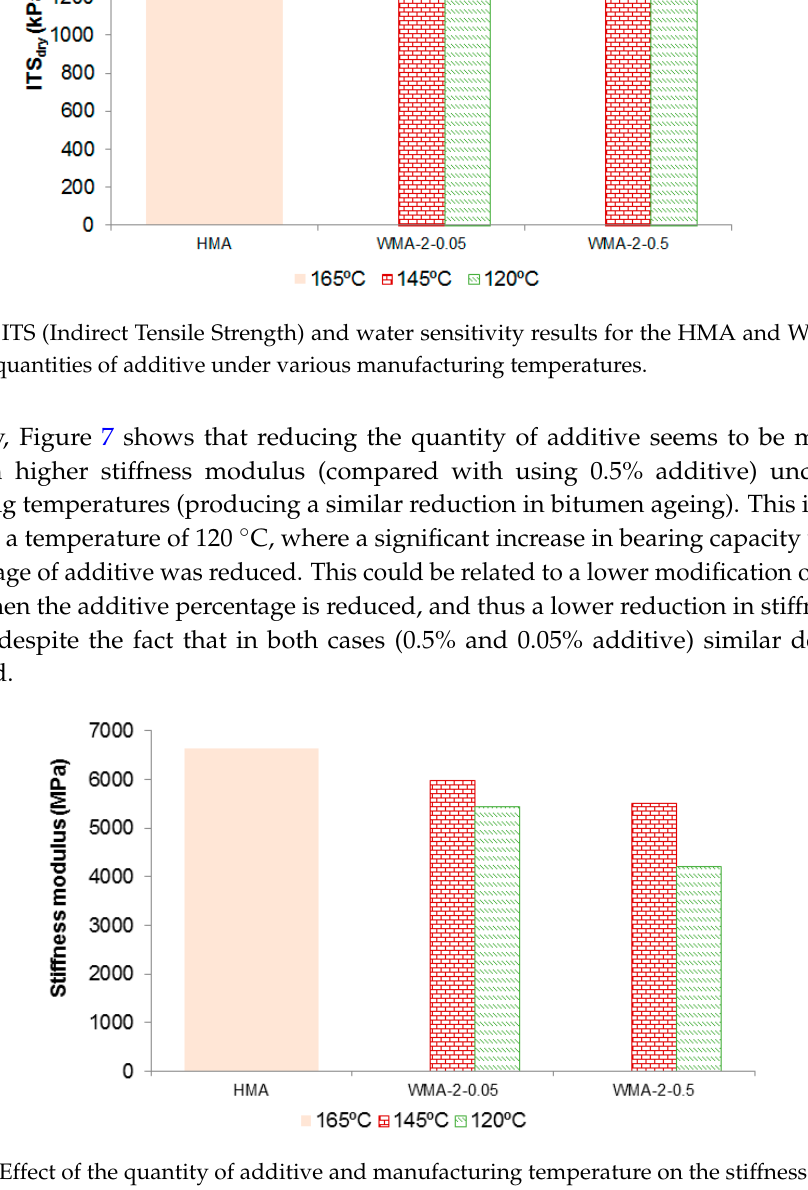
Figure 7. Effect of the quantity of additive and manufacturing temperature on the stiffness modulus of WMA.